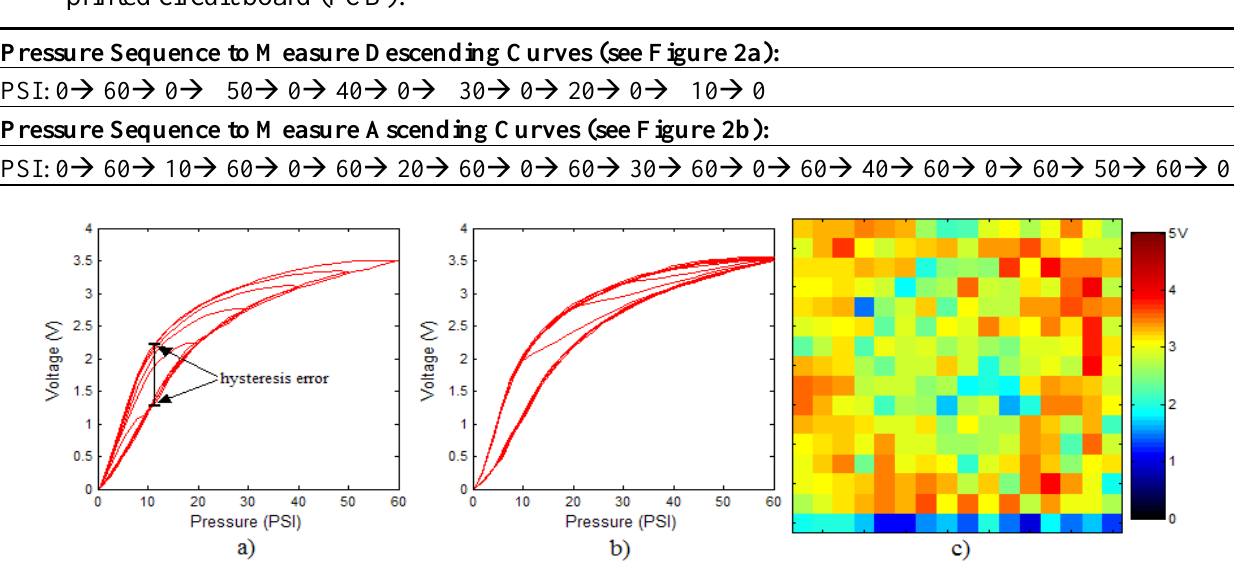
Figure 2. ( a ) Descending behavior of hysteresis curves; ( b ) Ascending behavior of hysteresis curves; ( c ) Mismatching presented by the tactile sensor at a pressure of